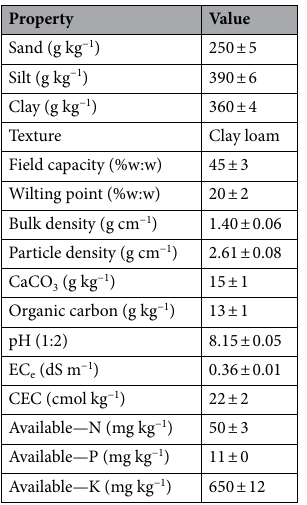
Table 1. Some physical and chemical properties of the studied soil. Each value (± SD) is the mean of five